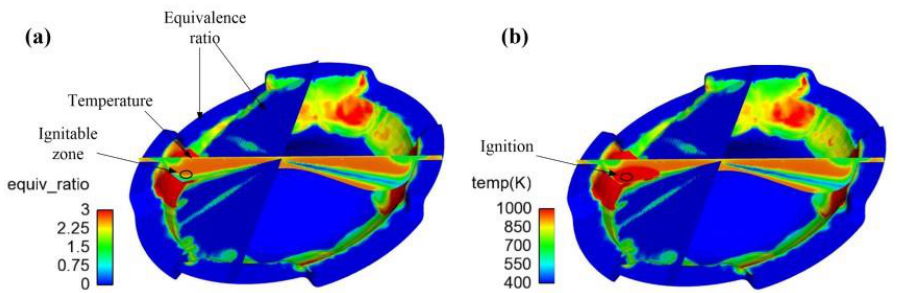
Figure 20. Distribution of equivalence ratio and temperature before and after ignition at 4.5 km: ( a ) −3.4 °CA ATDC; ( b ) −3.2 °CA ATDC.